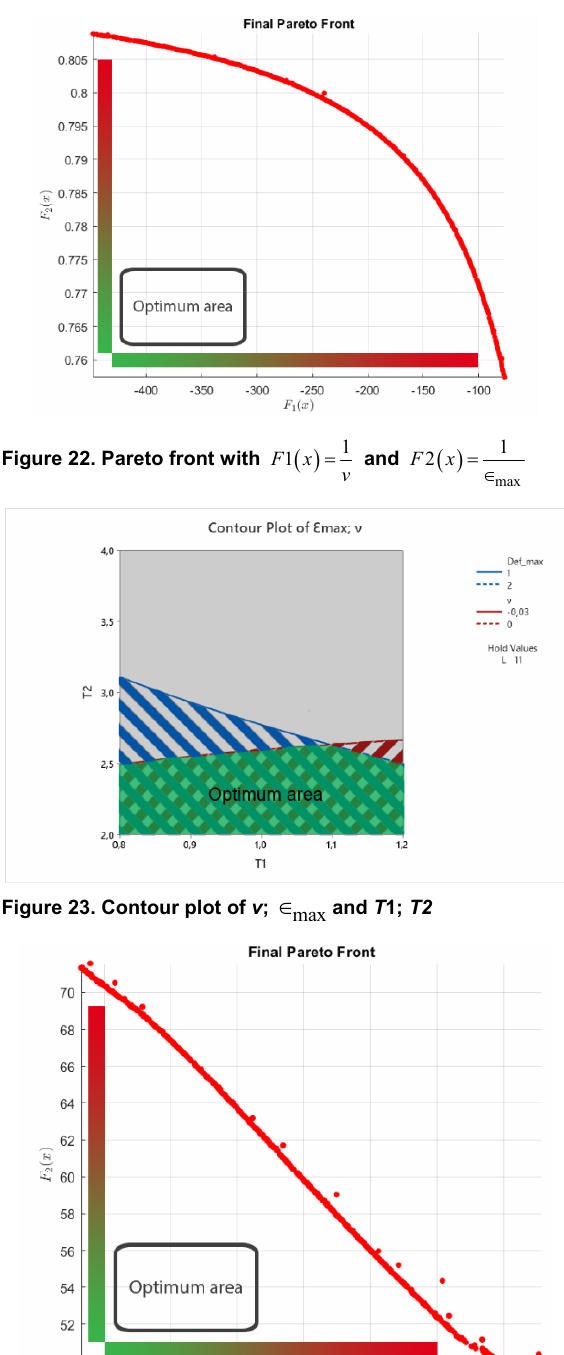
Figure 24. Pareto front with